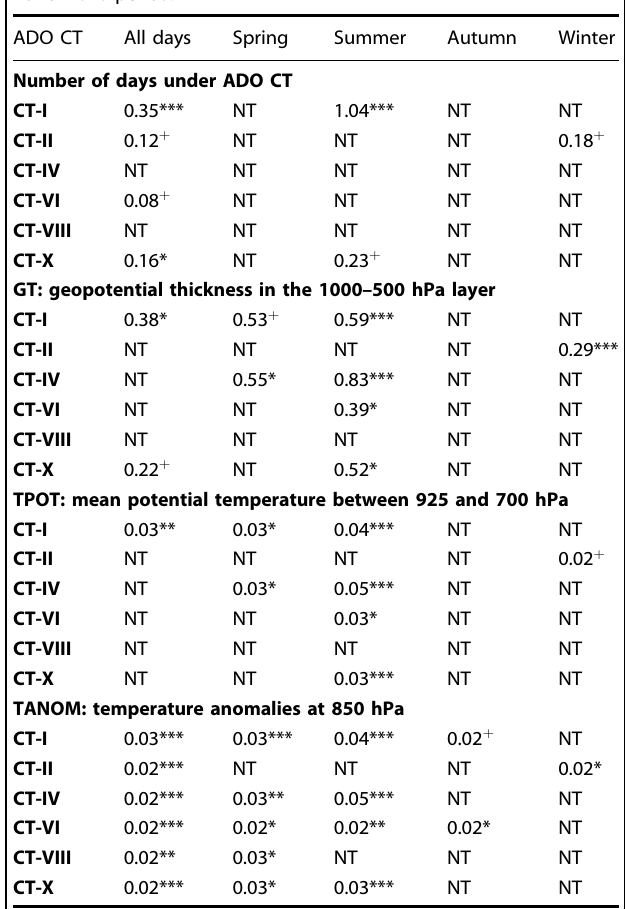
Table 2. Trend analysis for days under speci fi c ADO CT for